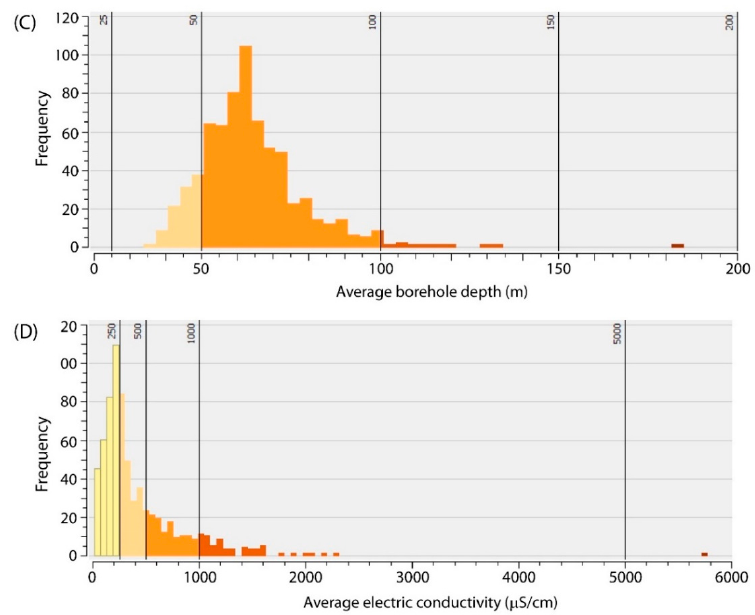
Figure 5. Frequency analysis of the available borehole data for each of the four borehole-related variables. ( A ) Borehole success rate (%). ( B ) Arithmetic mean of borehole yield (m 3 /h). ( C ) Arithmetic mean of borehole depth (m). ( D ) Arithmetic mean of electrical conductivity ( μ S/cm).